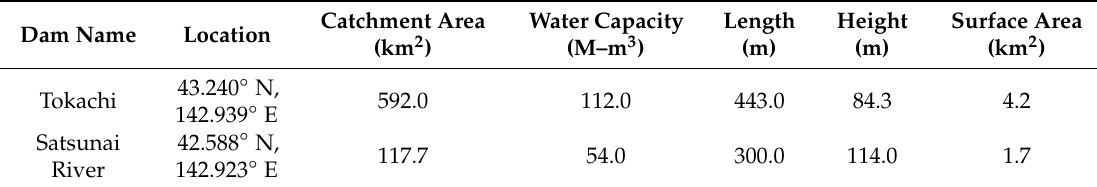
Table 2. Flood control dam